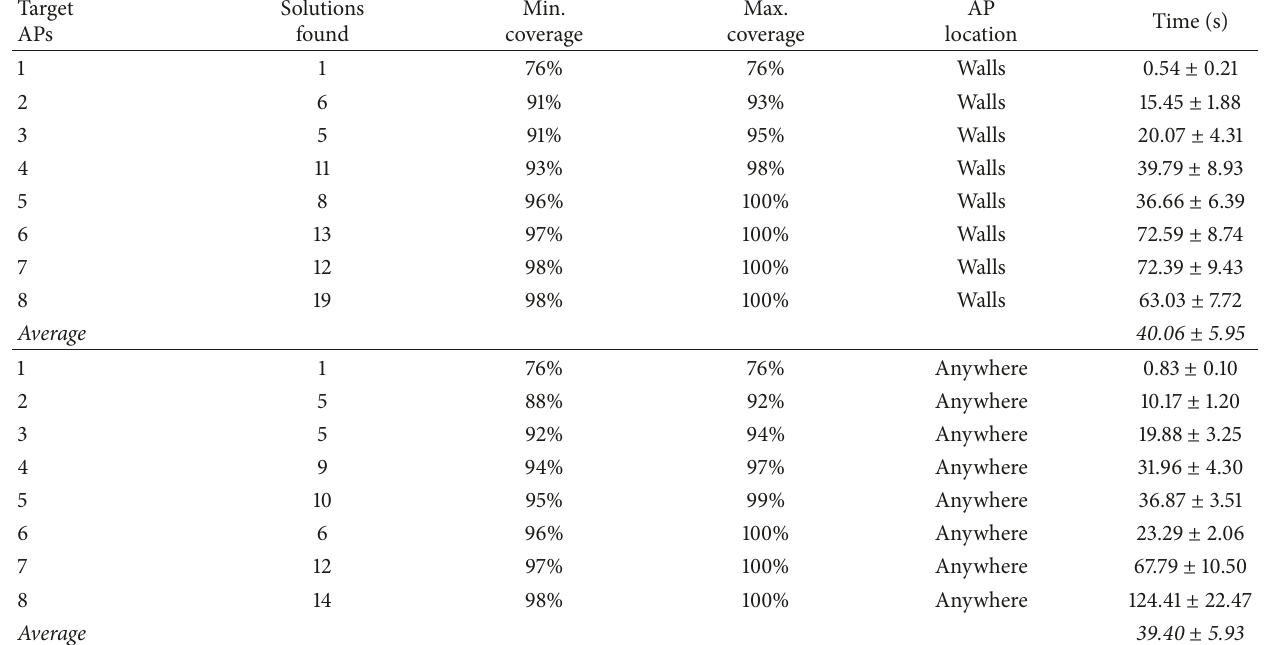
Table 6: Performance of SSGA in a medium